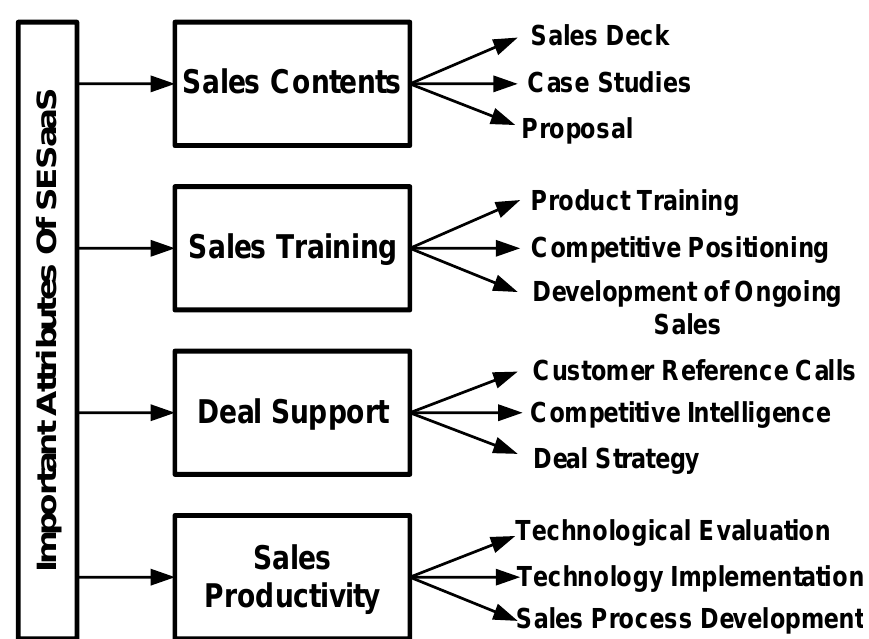
Figure 2. Essential attributes for SESaaS.